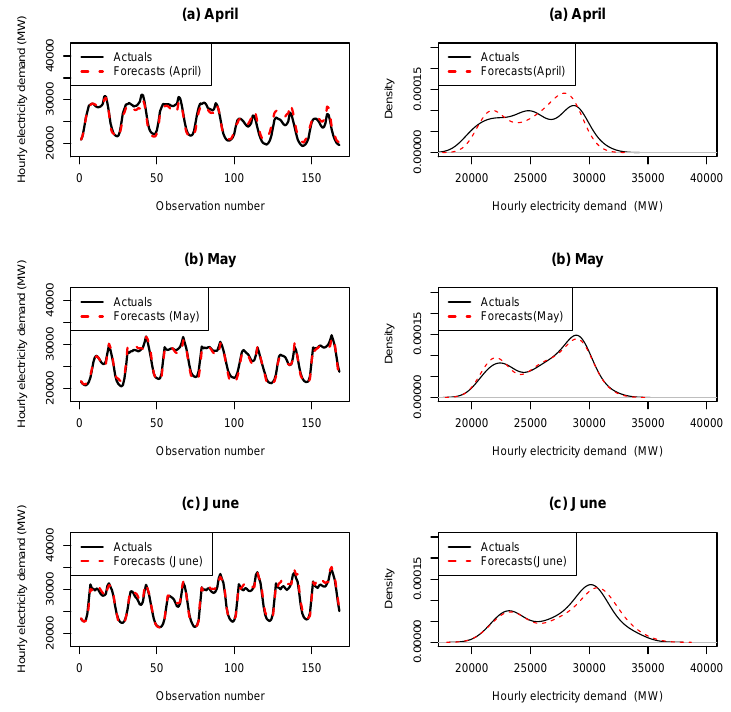
Figure A1. Hourly load superimposed with forecasts for the first 168 forecasts of each month of the months April to June 2012 together with their respective densities.